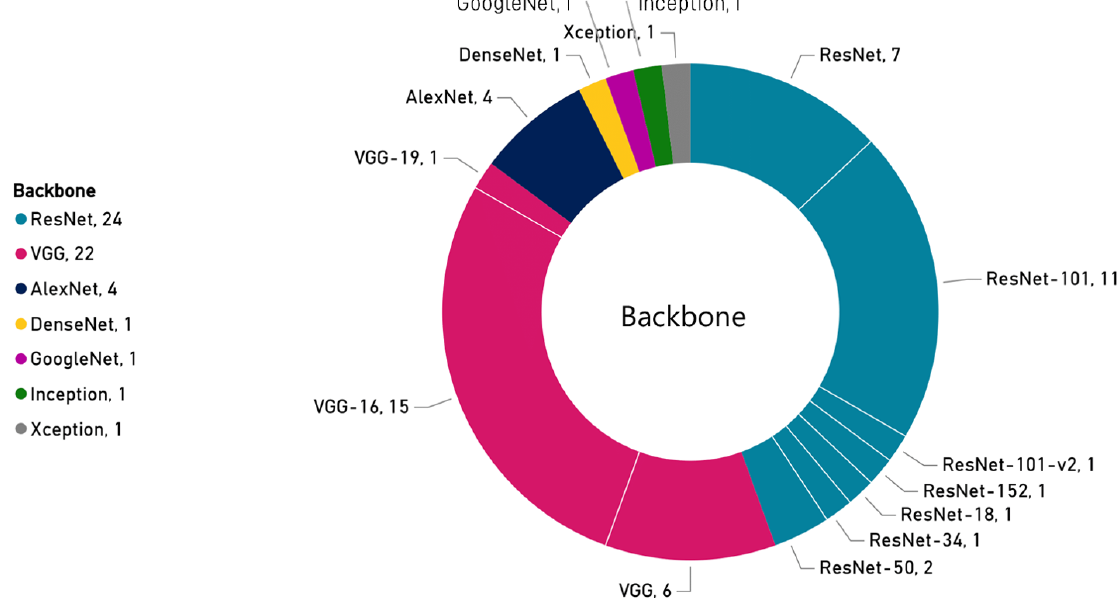
Figure 5. Overview of the convolutional backbones employed. Out of the papers that mentioned the use of backbones, the most commonly employed are ResNet and Visual Geometry Group (VGG). As many papers used multiple DL architectures, more than one backbone is used by those